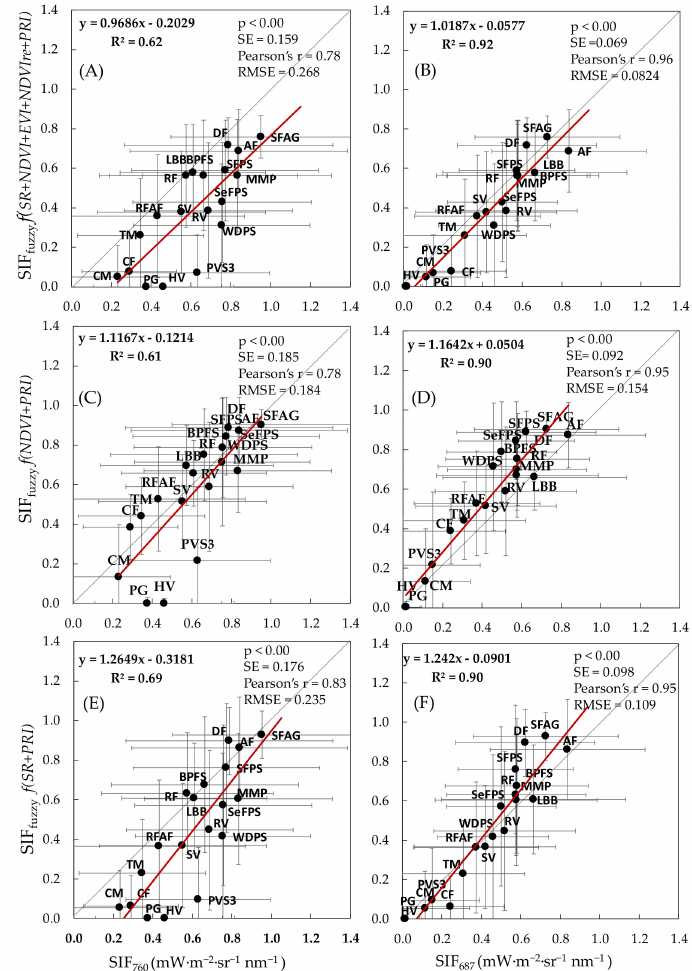
Figure 7. Scatterplots of the best performing fuzzy logic model outputs (SIF fuzzy ) and actual SIFs (SIF 760 and SIF 687 ) were determined based on HyPlant airborne data. ( A , B ) SIF fuzzy expressed by f (NDVI+EVI+NDVIre+SR+PRI) under model C6; ( C , D ) SIF fuzzy expressed by f (NDVI+PRI) under model C3; ( E , F ) SIF fuzzy expressed by f (SR+PRI) under model C4. Standard deviations are represented in error bars. The letter abbreviations correspond to the codes of vegetation groups presented in Figure